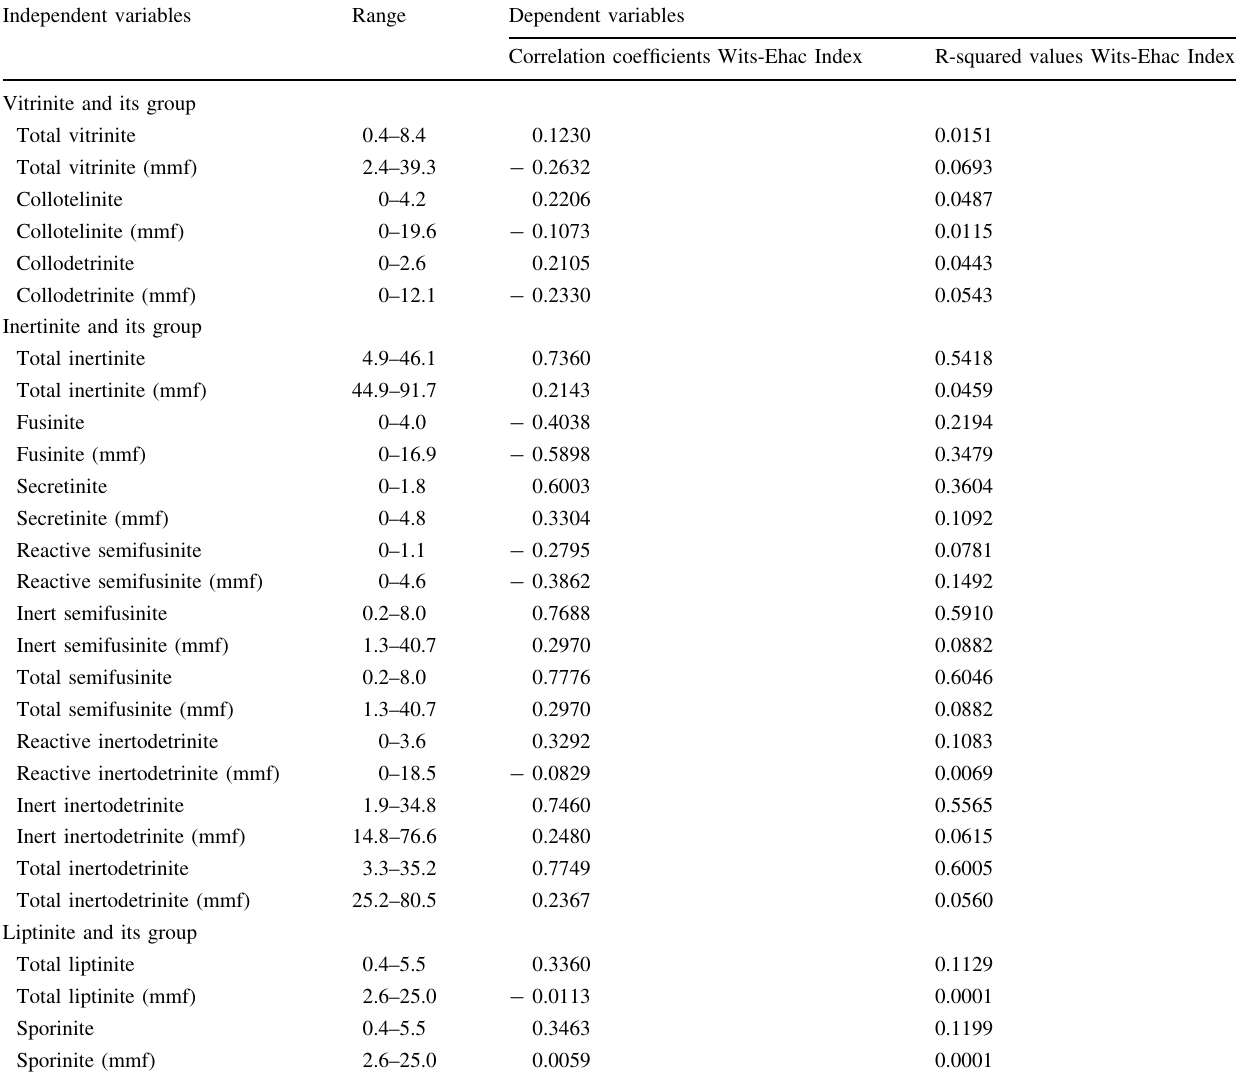
Table 6 Relationships between independent (petrographic analysis-vol%) and dependent variables for the coal-shale